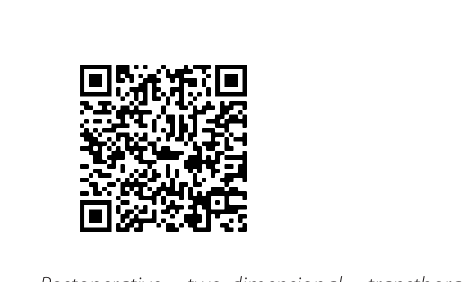
connected to the right ventricular basal free